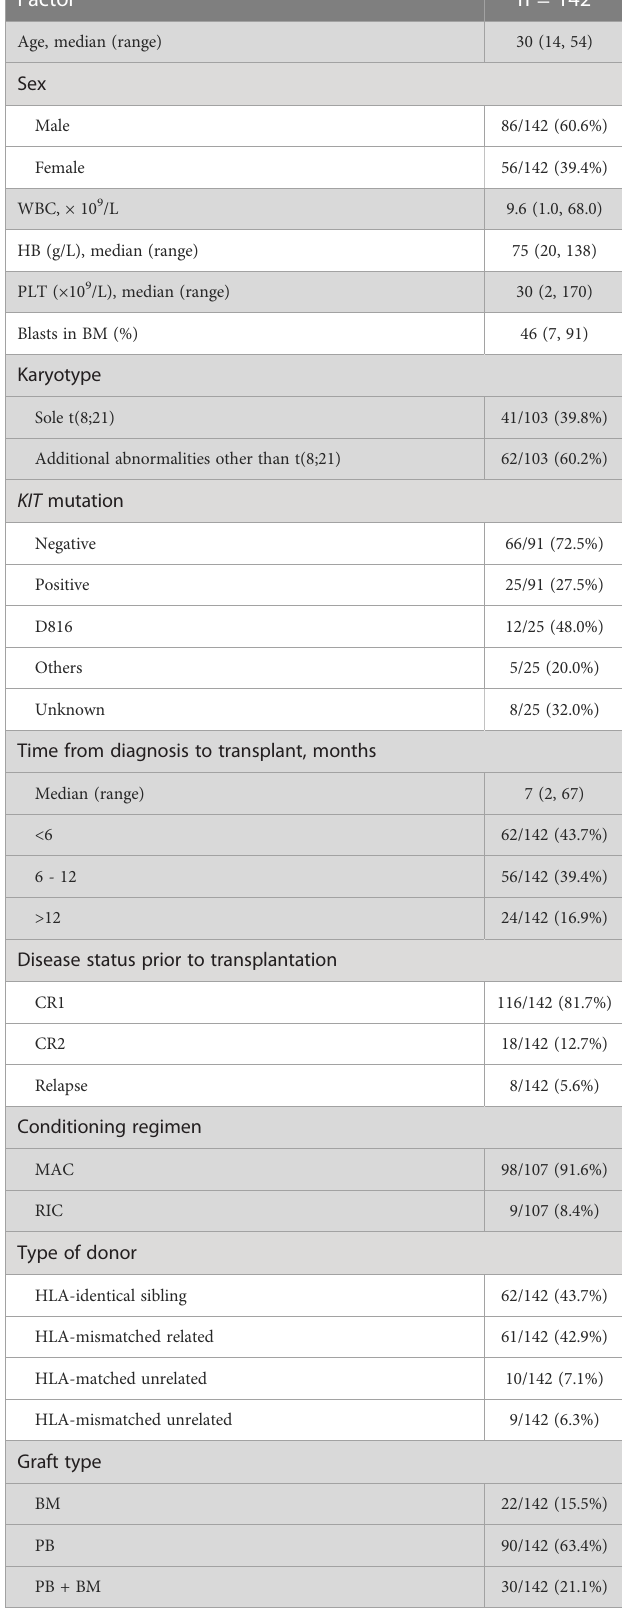
TABLE 1 The clinical characteristics at diagnosis and transplant-related events of 142 patients undergoing allo-HSCT.